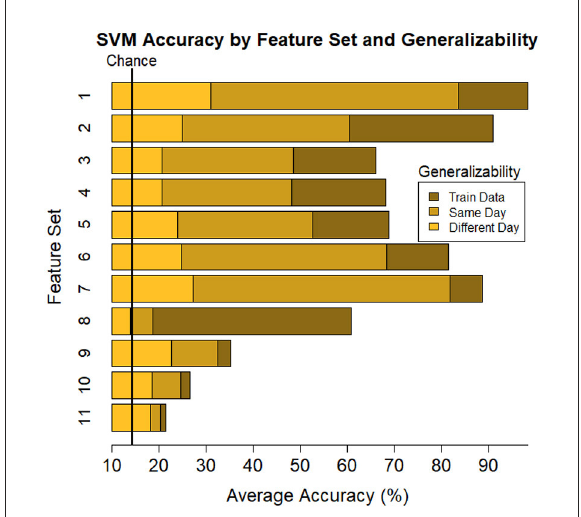
FIGURE5 Plot of summary of individuals’ classifier accuracy to predict type of task(s): T, C, M, T+C, T+M, C+M, T+C+M, for each feature subset outlined in Table 1. The number of features decreases from top (Set #1) to bottom (Set #11) in a nonlinear fashion, see Table 4 # of features . Numeric averages are provided in Table 4. Chance performance was 1 of 7 (14.3%). Set number refers to the electrode and bandwidth pairs included in the feature set used for classification. 1) All electrodes ( δ , θ , α , β , γ ), 2) All electrodes ( α , θ ), 3) All electrodes ( δ ), 4) All electrodes ( θ ), 5) All electrodes ( α ), 6) All electrodes ( β ), 7) All electrodes ( γ ), 8) All electrodes ( α/ ( β + θ )), 9) F7( α , θ ), Fz( α , θ ), Pz( α , θ ), P7( α , β ), O2( α , β ), 10) Pz ( δ , θ , α , β , γ ), 11) Fz( θ ), Pz( α ). Same day refers to the average score across both classifier Index 1 and 2 (Table 2) such that Day 1 or Day 2 was both used for training and testing the model. Different day refers to the average score across both classifiers Index 3 and 4 (Table 2). In model Index 3, Day 1